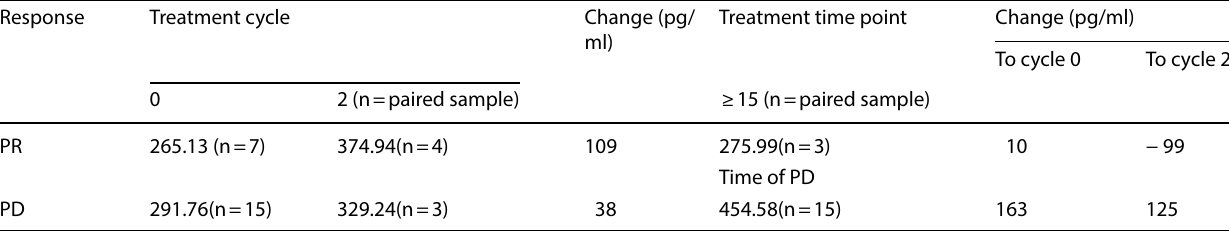
Table 2 Median values and changes in functional sPDL1 in PD and PR groups during anti-PD-1 treatment Response